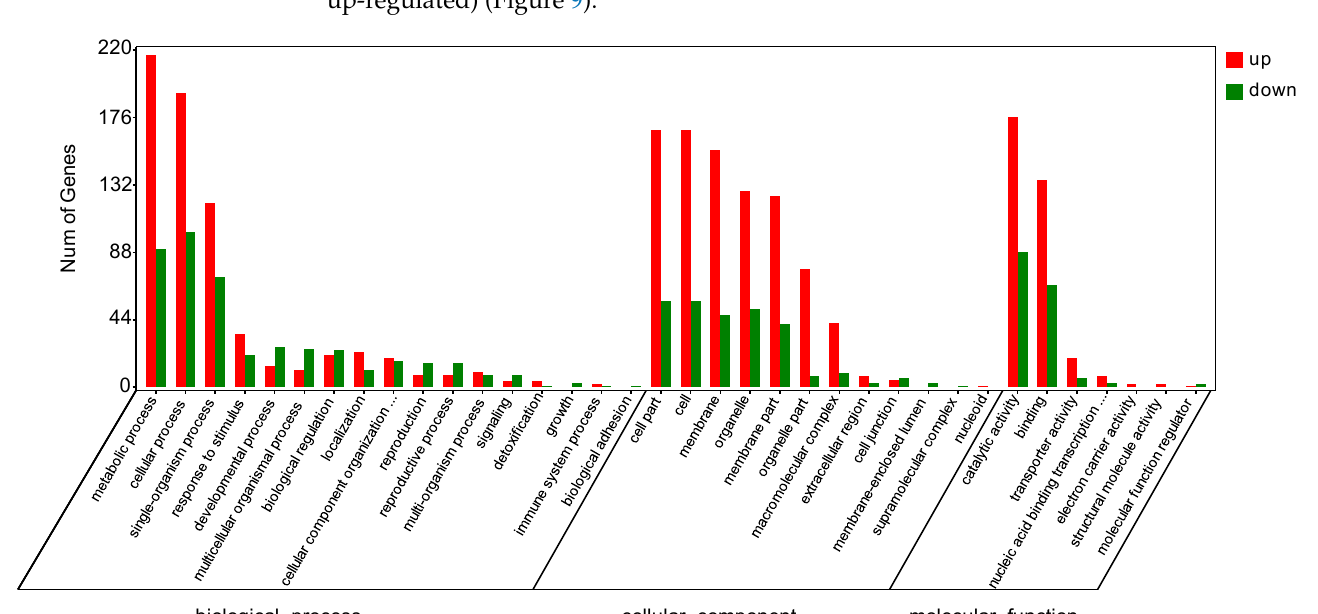
Figure 9. Classification of differentially expressed genes (DEGs) by gene ontology (GO) analysis: CK vs. LN.